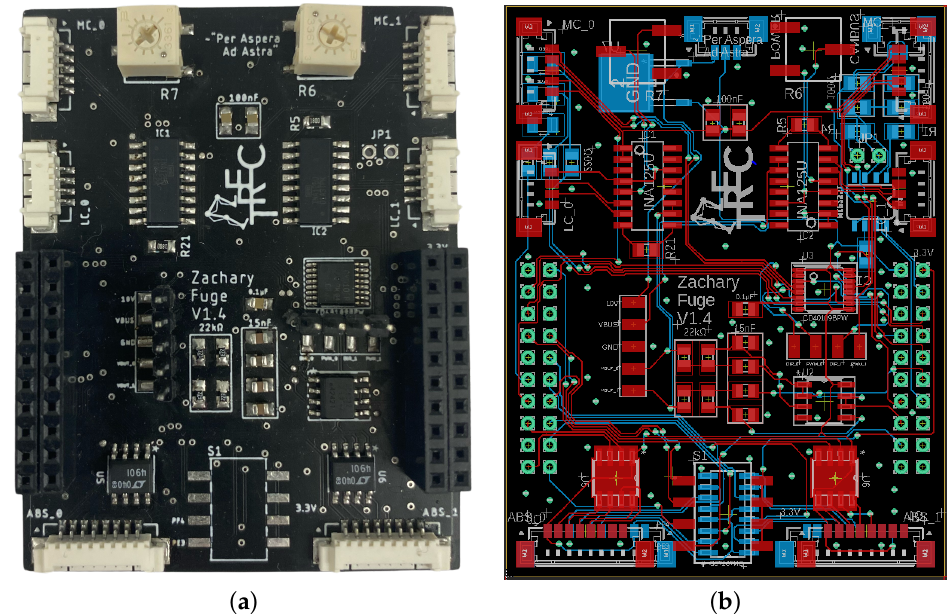
Figure 3. The sensor interface shield handles two sets of feedback for LSEAs systems, including force sensor conditioning, PWM logic step-up, quadrature encoder signal redundancy, and absolute en- coder feedback. ( a ) Physical build of sensor interface shield. ( b ) PCB layout of sensor interface